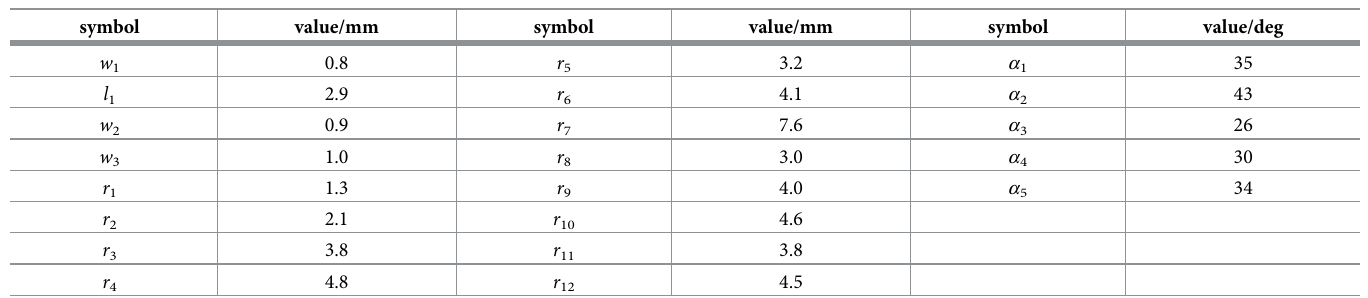
Table 2. Parameters of UWB filter structure.